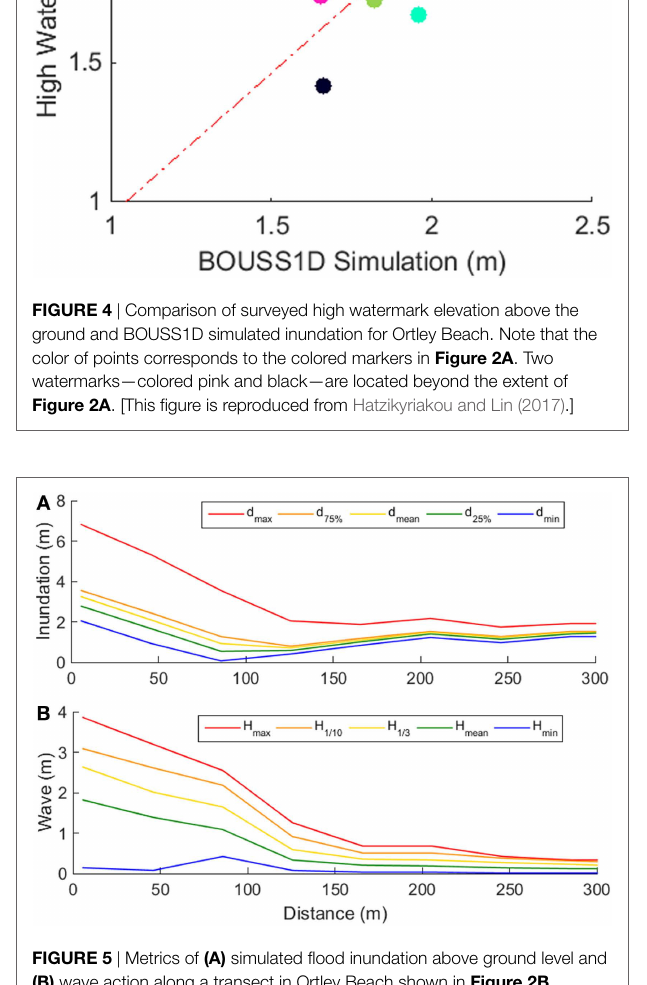
Dune profiles before and after Sandy are determined by con- verting the LiDAR point data into rasters with a 1.5 m cell